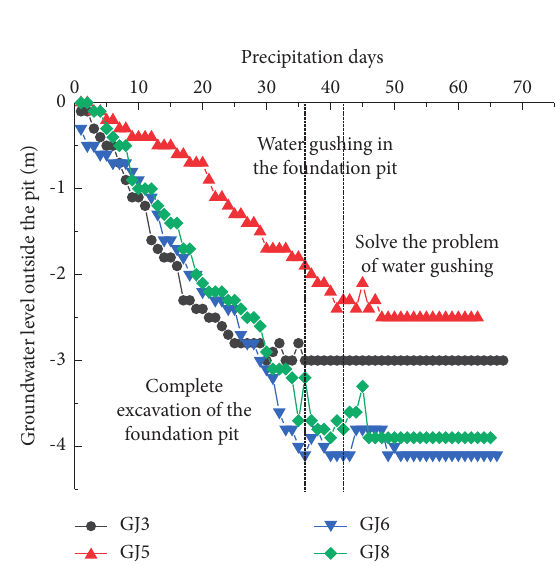
Figure 7: Water-level change curve outside the